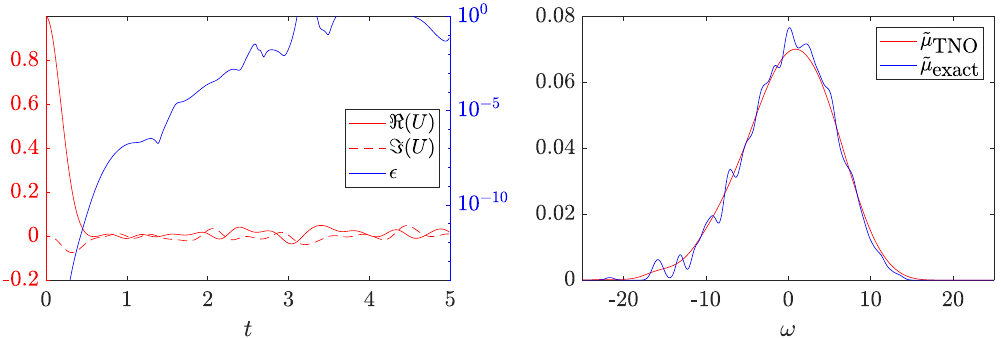
Figure 4: Results for the density of states of the longitudinal-field Ising model [ Eq. (46) ] with g = 1 and h = 1 on a ring of 10 sites. In the left panel, the red lines show the real and imaginary parts of U ( t ) = Tr ( e − i ˆ Ht ) ; the blue line shows the deviation between the exact result and the TNO. The right panel shows the smeared ˜ µ ( ω ) calculated exactly ( T = 2) and with TNO ( T =